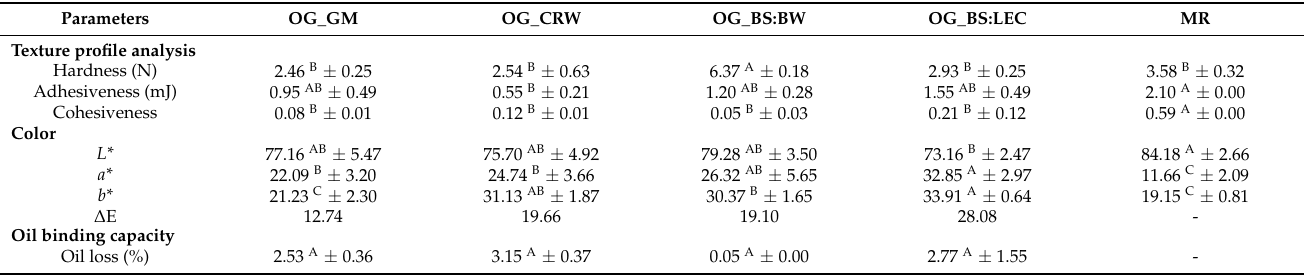
Table 1. Textural properties, color, and oil structuring capacity of oleogel samples containing different